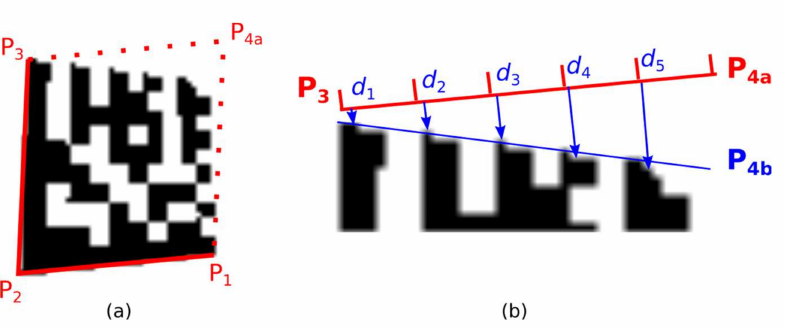
Figure 14. Perspective distorted Data Matrix code. ( a ) the initial estimate of the position of point P 4 ; ( b ) distances from line segment P 3 -P 4a to Timing Pattern of Data Matrix